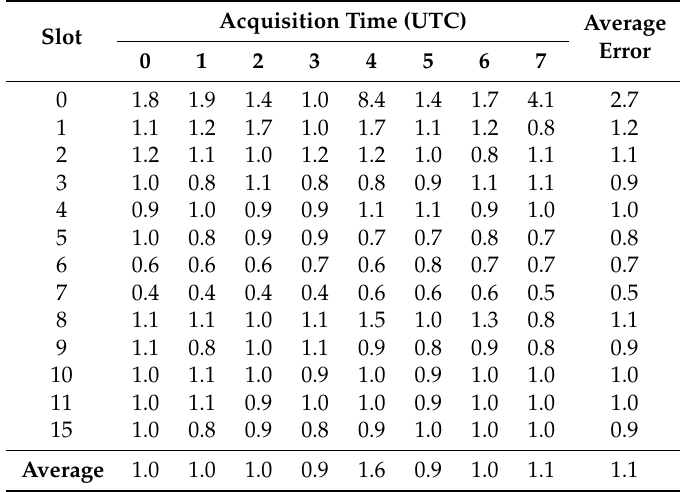
Table 4. RMSE of geometric correction with precision sensor modeling (in km). Slot